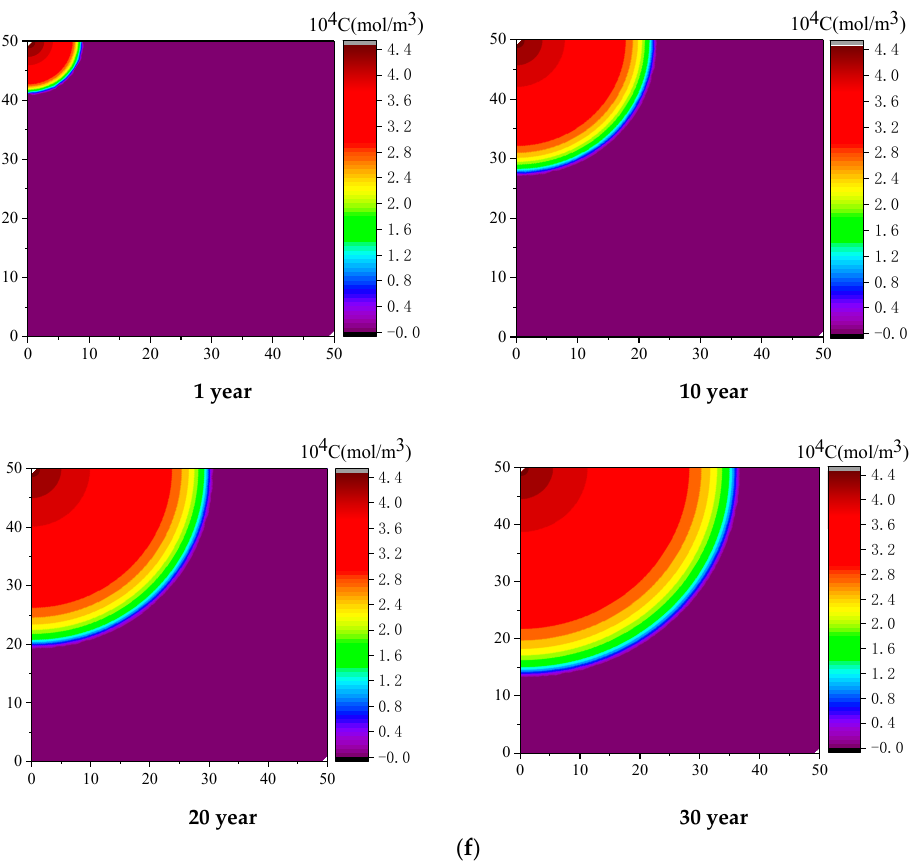
Figure 7. Distribution of CH 4 and CO 2 molar concentrations under different CO 2 injection temperatures: ( a ) distribution of CH 4 molar concentration at 303 K injection temperatures; ( b ) distribution of CO 2 molar concentration at 303 K injection temperatures; ( c ) distribution of CH 4 molar concentration at 333 K injection temperatures; ( d ) distribution of CO 2 molar concentration at 333 K injection temperatures; ( e ) distribution of CH 4 molar concentration at 363 K injection temperatures; and ( f ) distribution of CO 2 molar concentration at 363 K injection temperatures.